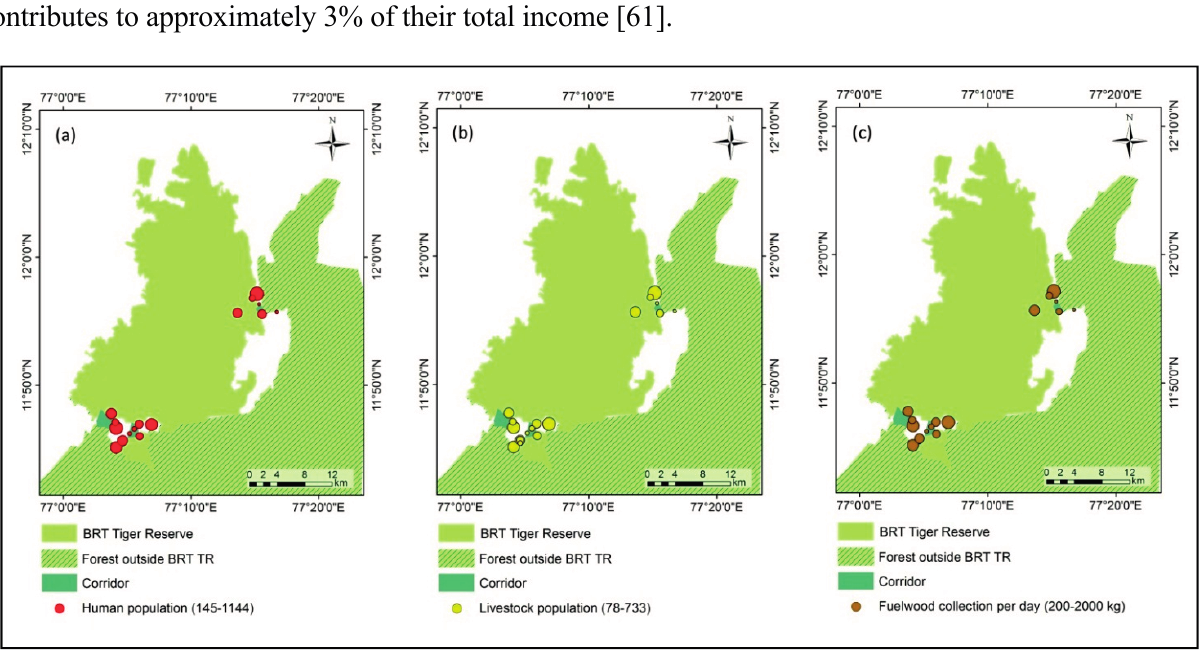
Figure 10. Dependence on corridors by local people in Biligiri Rangaswamy Temple Tiger Reserve (BRT). ( a ) Human population per village, ( b ) livestock population per village, and ( c ) fuel wood collection per day per village (in kgs). In each class, the range is given in the bracket next to the circle and the size of the circle indicates the magnitude of the respective